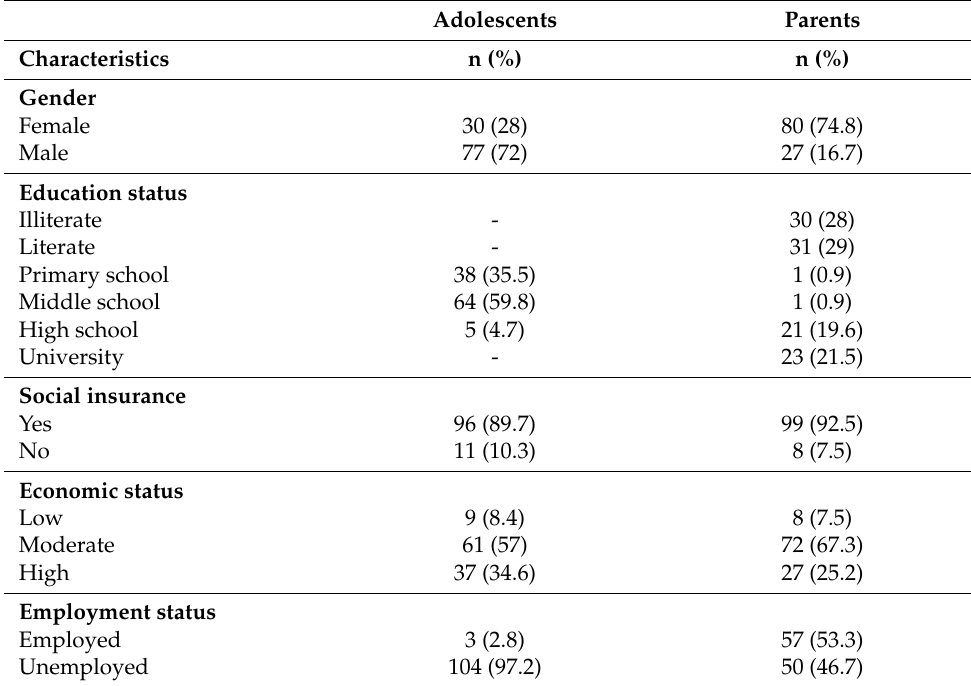
Table 1. Socio-demographic characteristics of the participants.